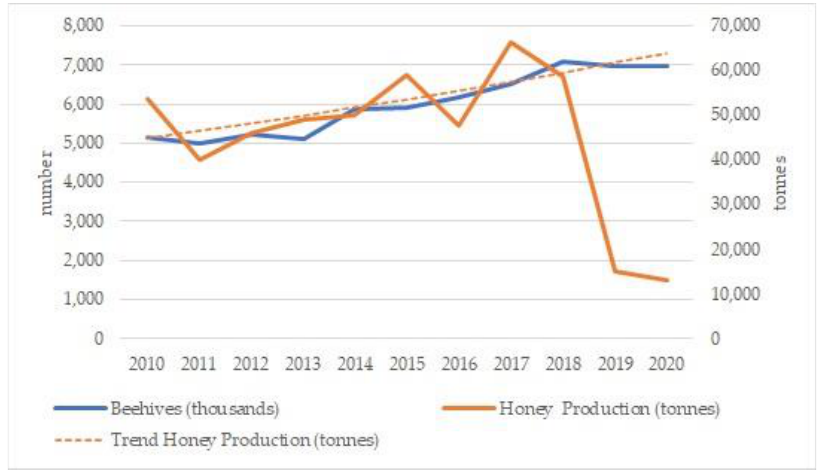
Figure 4. Beehives and honey production in Ethiopia, 2010 – 2020. Source: FAOSTAT [72].